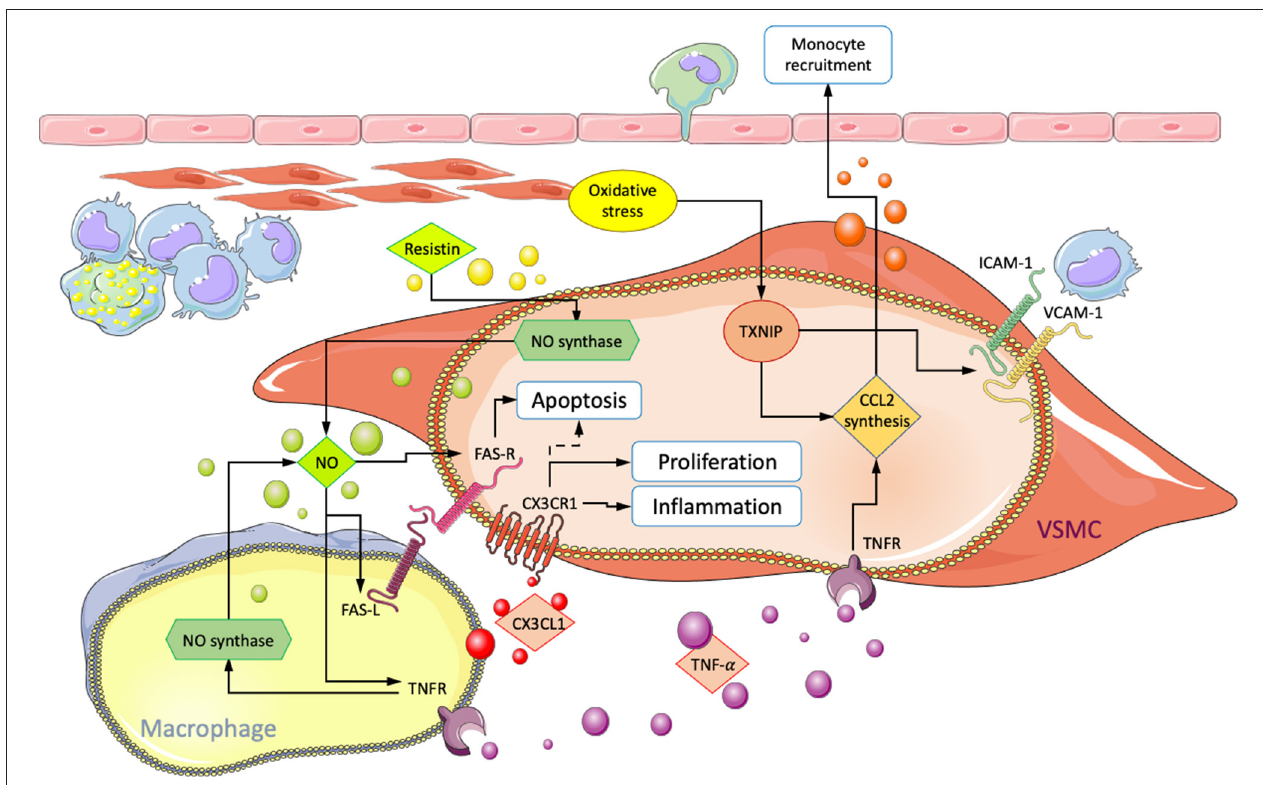
FIGURE 3 | Summary of interactions involving physical contact between macrophages and VSMCs in atherosclerosis. Arrows point in the direction of enhanced processes, and dotted lines indicate inhibition. CX3CL1/CX3CR1 interaction leads to increased VSMC accumulation and inflammation. ROS-mediated increase in VCAM1/ICAM1 and CCL2 result in enhanced subendothelial macrophage retention and monocyte recruitment, respectively. Fas-mediated VSMC-apoptosis and the influence of NO, TNF- α , and resistin on FAS-R/L surface